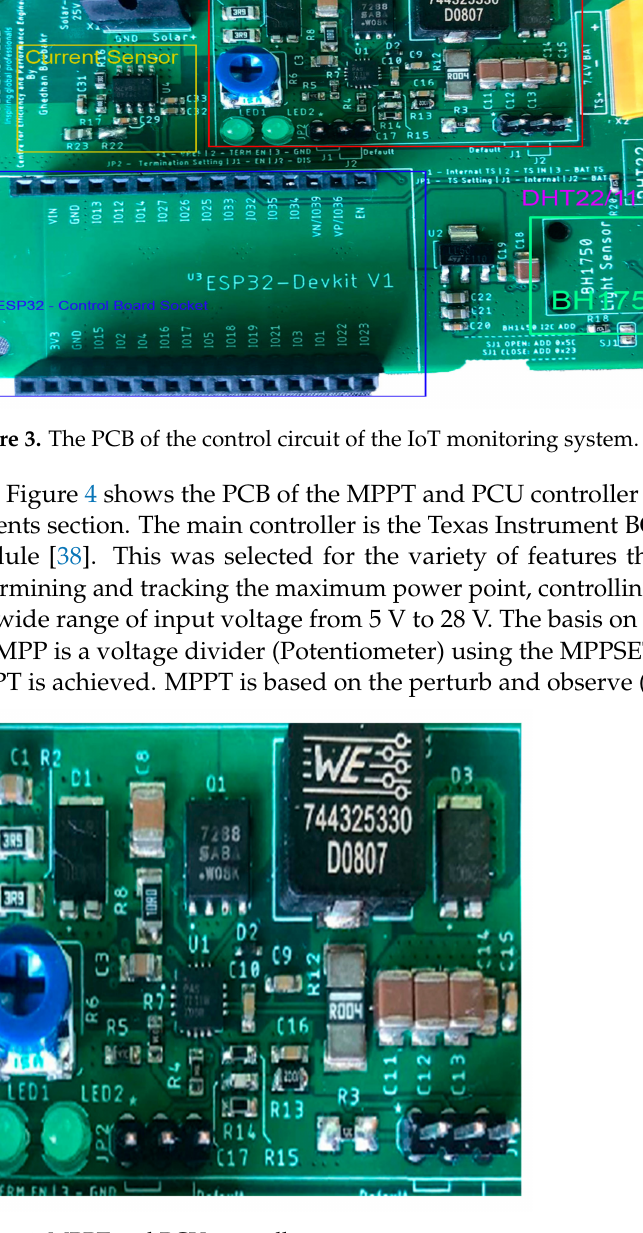
Figure 4. MPPT and PCU